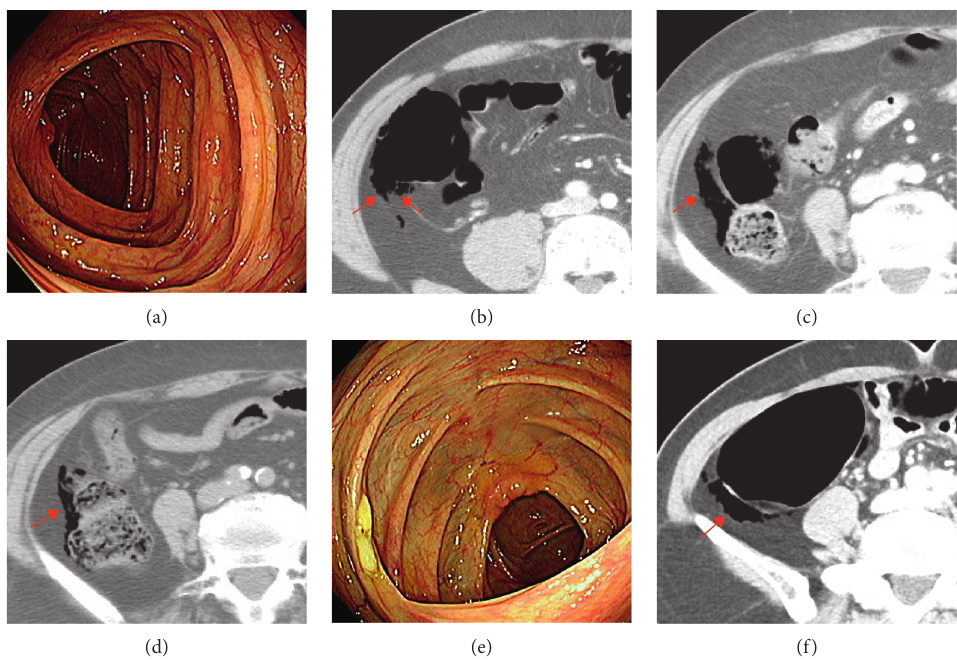
Figure 1: (a) Normal colonoscopic findings in case 1. (b) Abdominal computed tomography (CT) shows a small amount of free air in the right paracolic gutter in case 1. (c) Abdominal CT shows a small amount of free air in the right paracolic gutter in case 2. (d) Follow-up CT scan shows a reduced pneumoperitoneum two months after its initial detection in case 2. (e) Normal colonoscopic findings in case 3. (f) Abdominal CT shows a small amount of free air in the right paracolic gutter in case